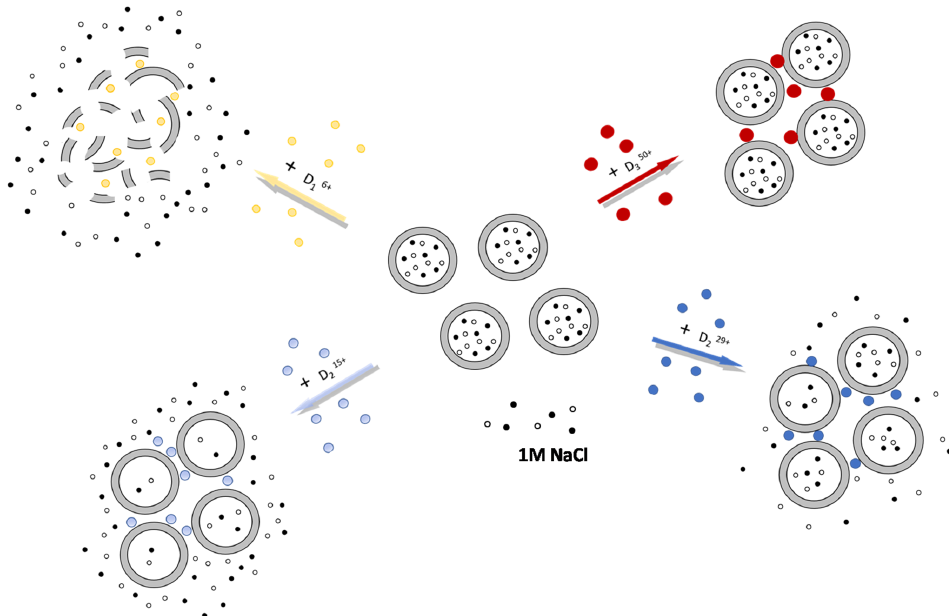
Figure 6. Schematic representation of interactions of liposomes with dendrimers. D 350+ and D 229+ did not display a disruptive effect toward the liposomes, while the complexation of liposomes with D 229+ was followed by minor defect formation. D 16+ induced significant destruction of liposomal mem- branes.